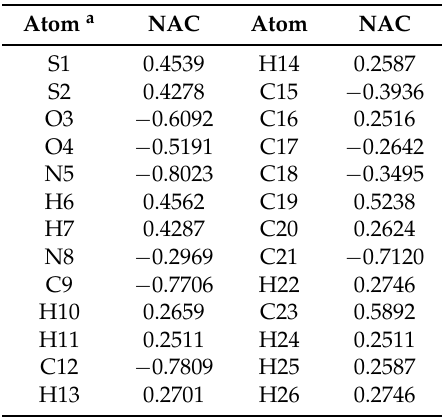
Table 4. The natural atomic charges calculated at the B3LYP/6-31G (d,p).